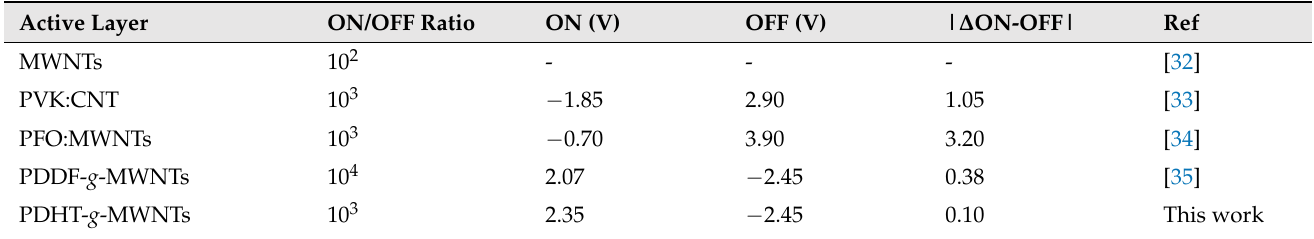
Table 1. Memory performance comparison with nonvolatile resistive memory based on carbon